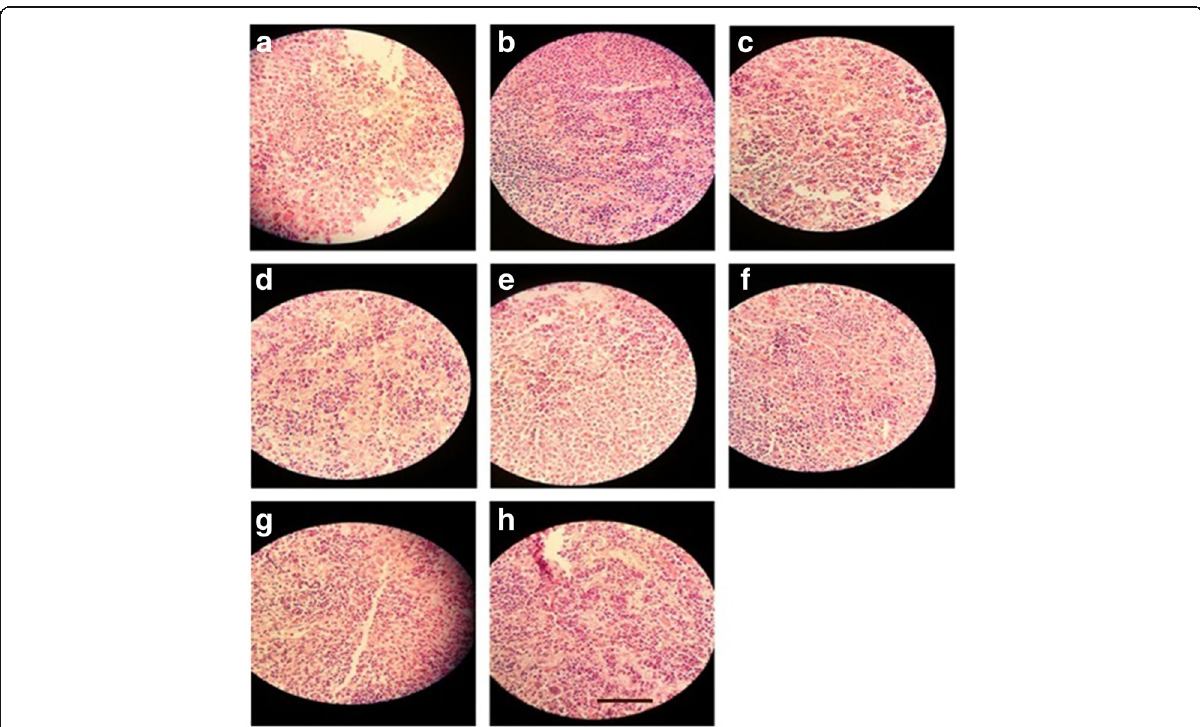
Fig. 4 Histopathological changes in the pancrease; a : Group I = Normal control, b : Group II = Diabetic wound control, c : Group III = Diabetic wound control +100 mg ethanolic extract of E. hirta , d : Group IV = Diabetic wound control +200 mg ethanolic extract of E. hirta , e : Group V = Diabetic wound control +400 mg ethanolic extract of E. hirta , f : Group VI = Diabetic wound control +5% Povidone iodine, g : Group VII = Diabetic wound control +5% ethanolic extract of E. hirta , h : Group VIII = Diabetic wound control +10% ethanolic extract of E. hirta. Each group was assessed at 400X magnification, scale bar: 40 μ